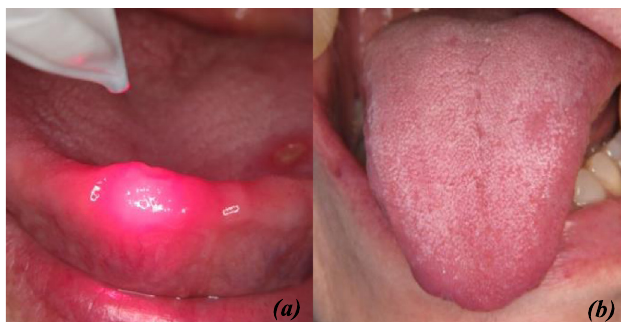
Fig. 2. (a) Laser biostimulation, (b) healing of the dorsal side of the tongue at 15